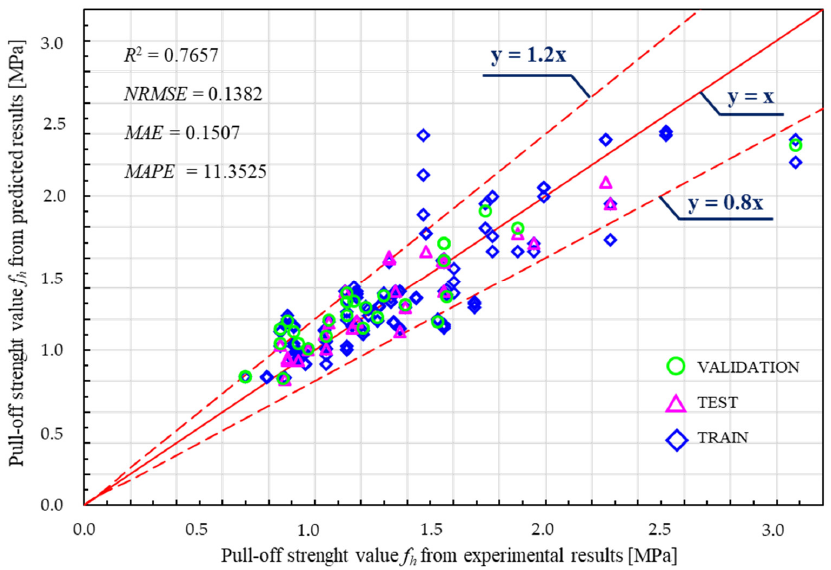
Figure 12. Relationship between the predicted value and the experimental value of the pull-off strength f h for ANN test, train, and validation process for the BFGS algorithm with two layers of hidden neurons.